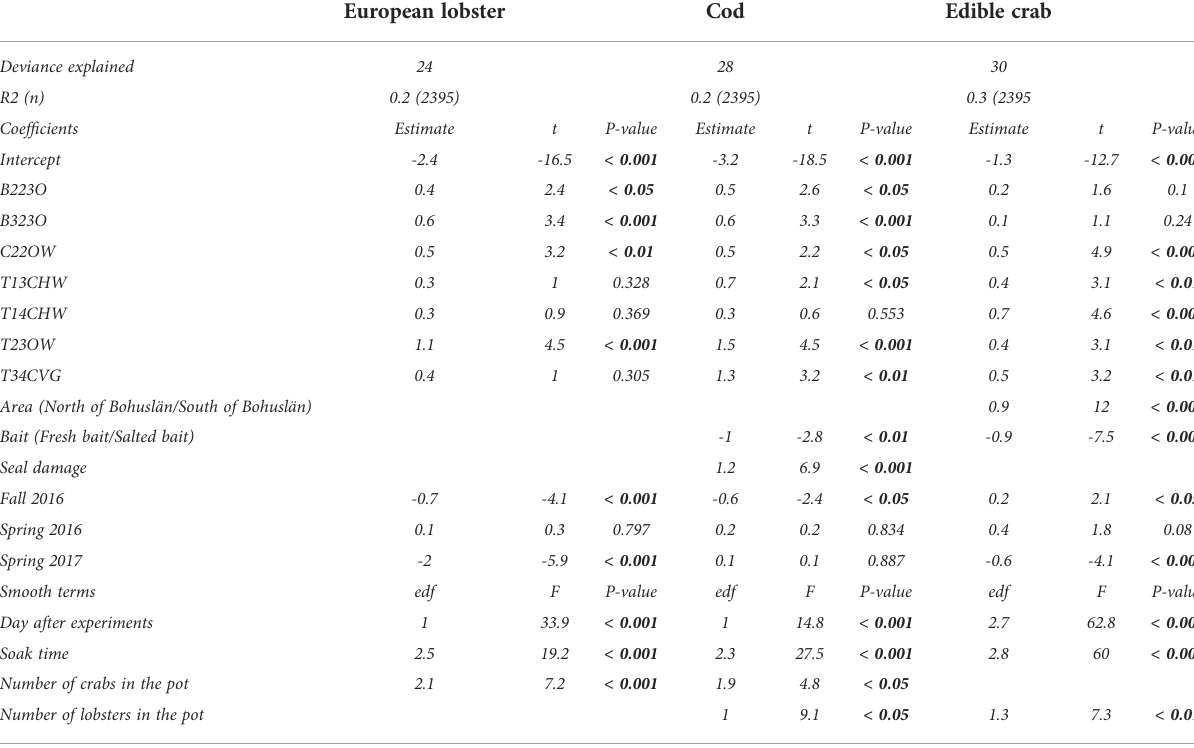
TABLE 6 Results of the best generalized additive model for CPUE of European lobster, cod and edible crab.